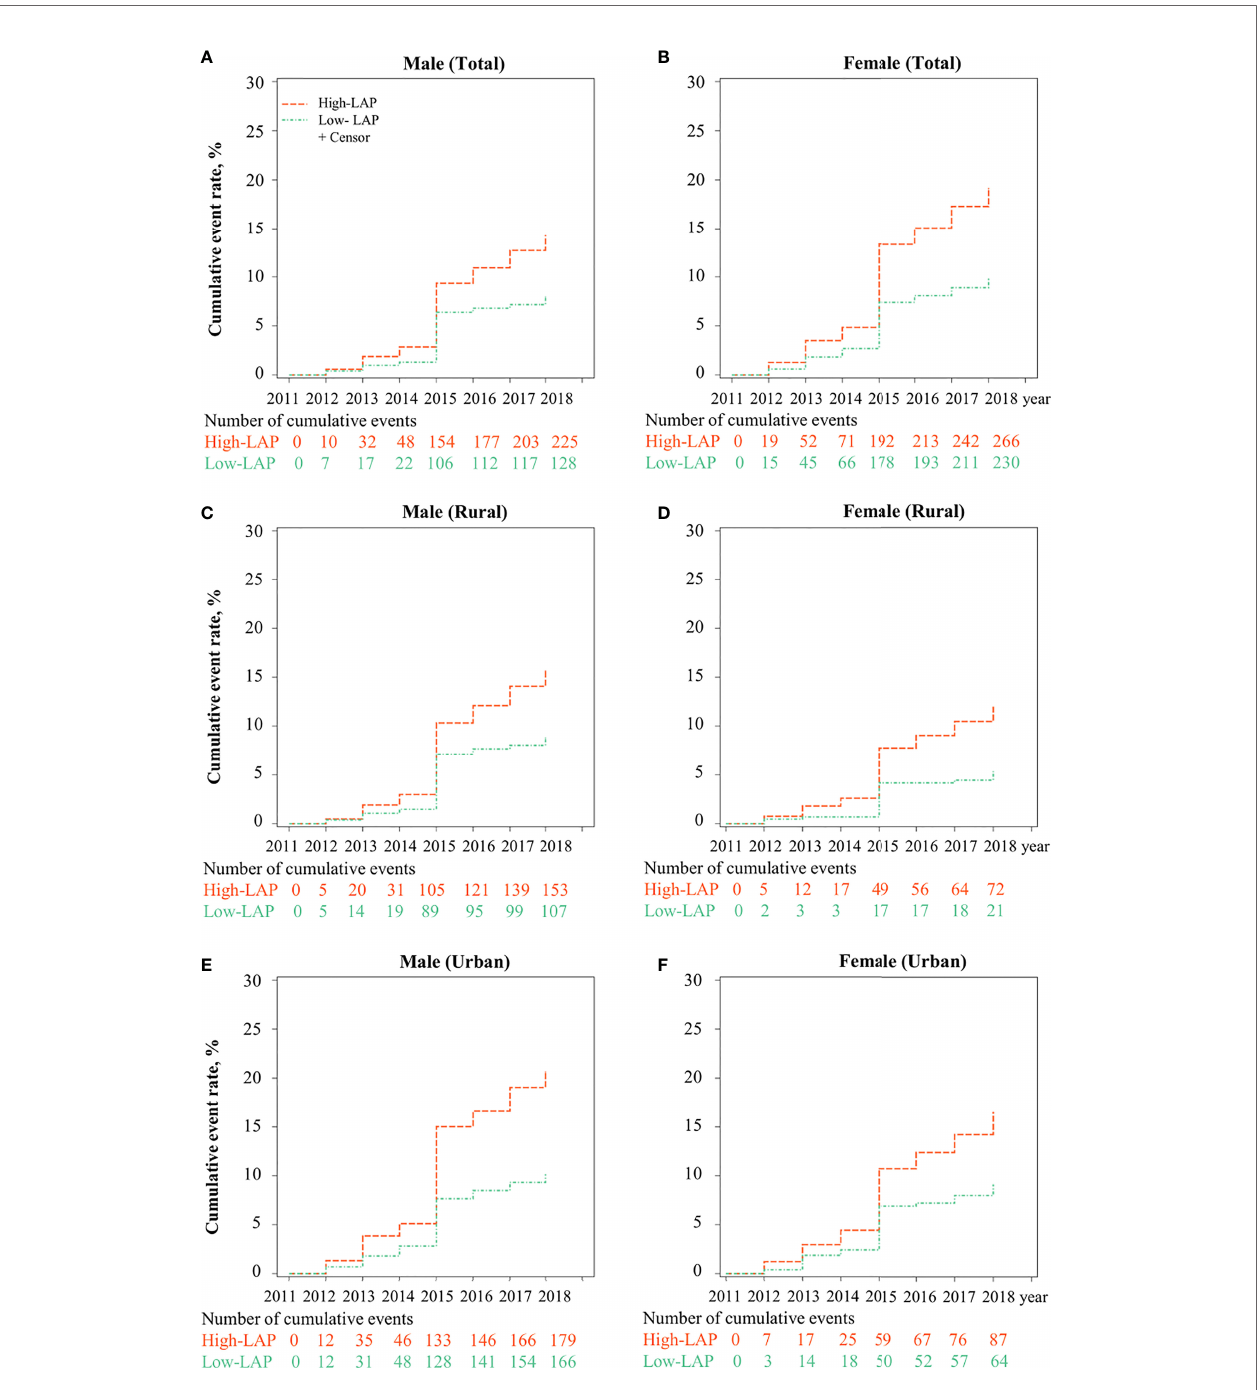
FIGURE 1 | Cumulative incidence of T2DM for LAP phenotypes (Low- and High-) strati fi ed by urban/rural settings and sex from CHARLS 2011 to 2018. LAP, lipid accumulation product; The cumulative event rate of T2DM was signi fi cantly different between low-LAP and high-LAP in (A) Male , (B) Female , (C) Male in rural , (D) Female in rural , (E) Male in urban, and (F) Female in urban